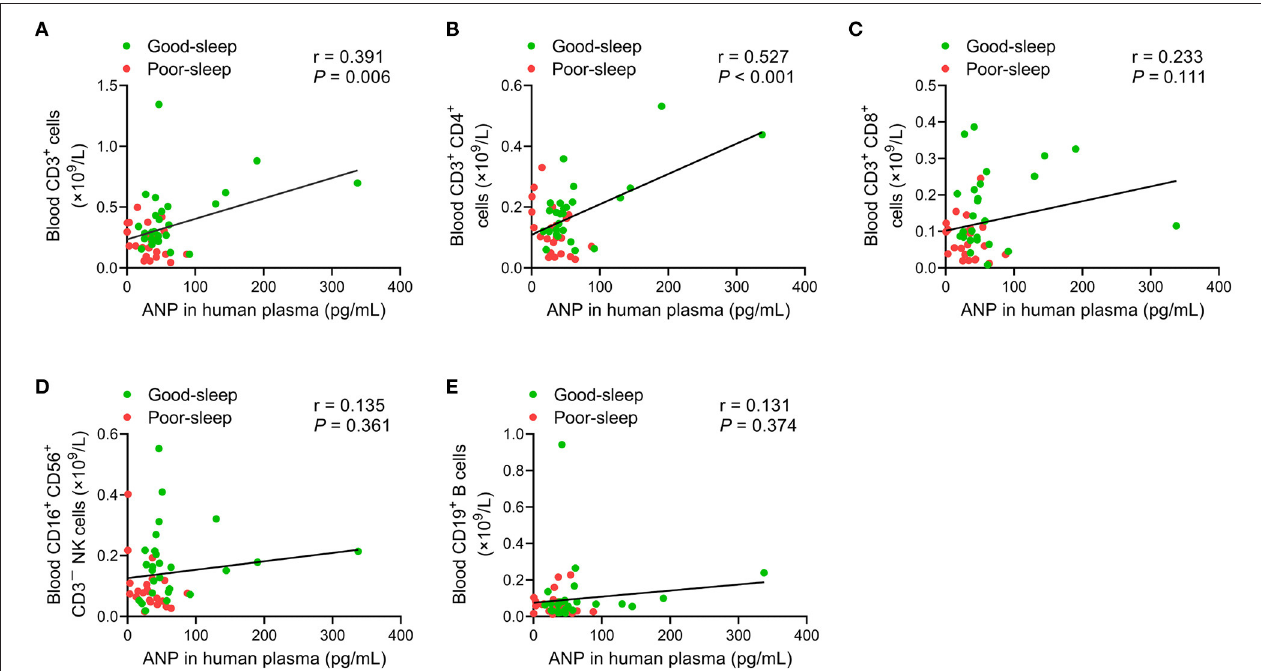
FIGURE 4 | Correlation analysis of the plasma levels of atrial natriuretic peptide (ANP) with lymphocyte subsets in the peripheral blood. The plasma levels of ANP at 24h after inclusion were positively correlated with the number of CD3 + T-lymphocytes ( r = 0.391, P = 0.006) (A) or the number of CD3 + CD4 + T-lymphocytes ( r = 0.527, P < 0.001) (B) on day 5 after inclusion. No significant correlations between the plasma levels of ANP at 24h after inclusion with the number of CD3 + CD8 + T-lymphocytes (C) , the number of CD3 − CD16 + CD56 + natural killer cells (D) , or the number of CD19 + B-lymphocytes (E) on day 5 after inclusion were